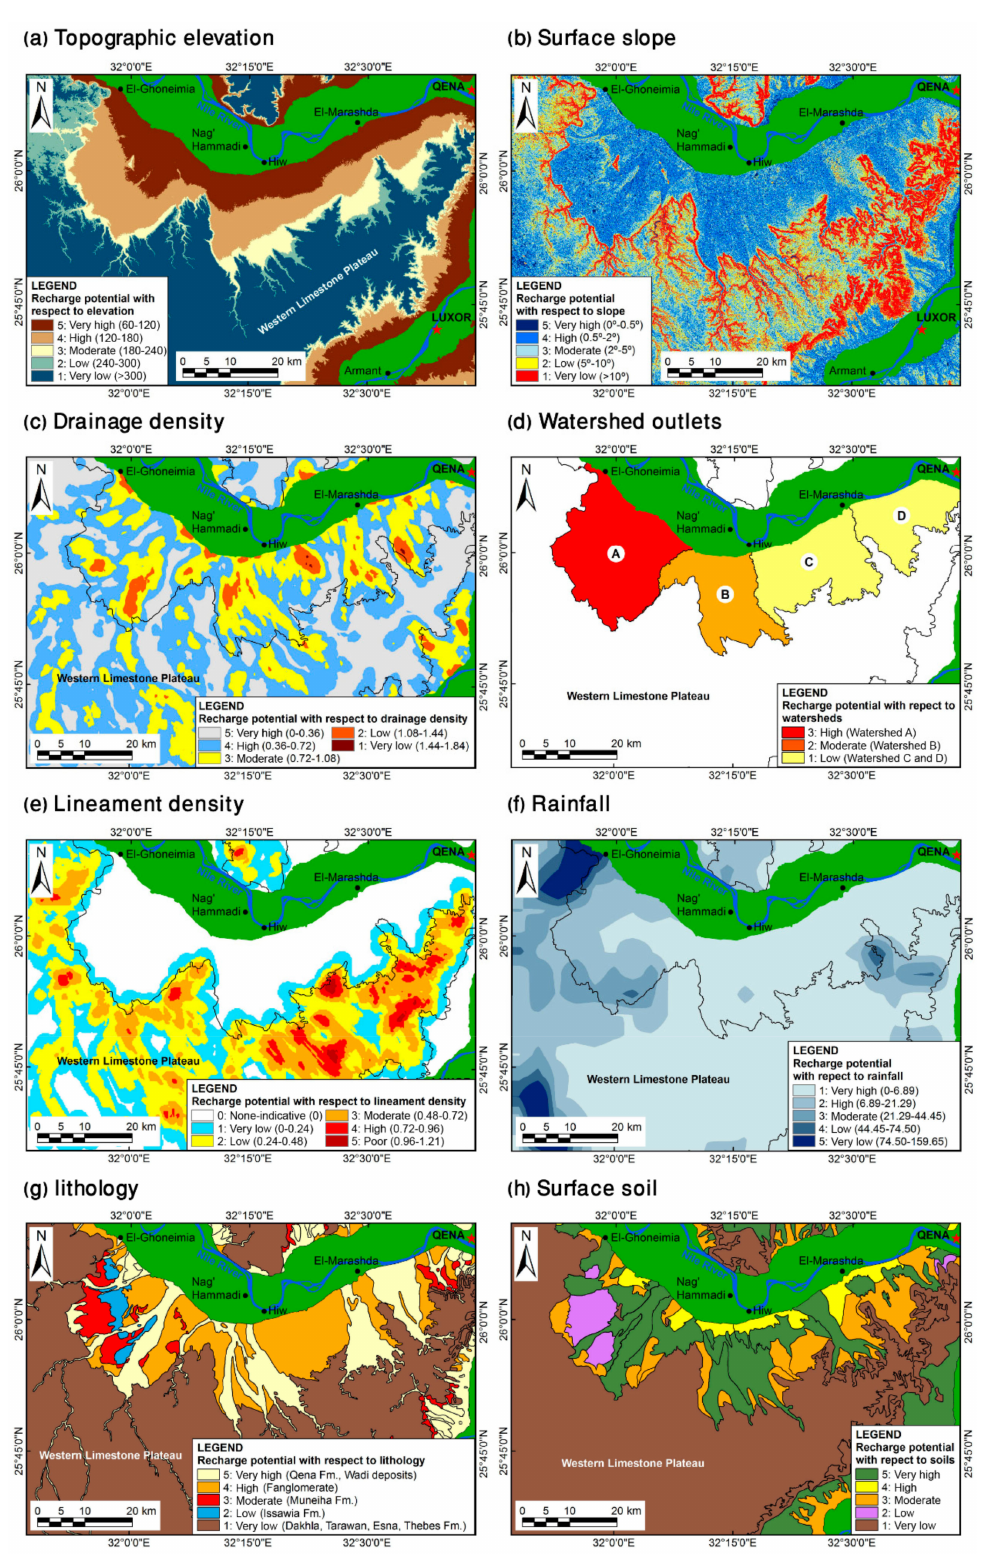
Figure 12. Thematic layers of the di ff erent factors influencing groundwater recharge